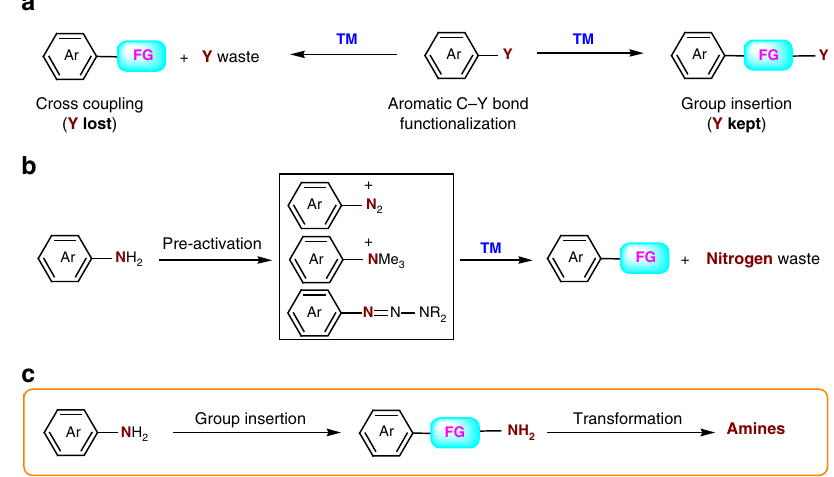
Fig. 1 Functionalization of aryl C – Y bonds: cross-coupling vs group insertion. a functionalization of aromatic C – Y bonds; b conventional functionalization of aryl C – N bonds (nitrogen lost); c functional group insertion into aryl C – N bonds (nitrogen kept). FG functional group, TM transition metal, Ar aryl group. FG in pink and in a cyan rectangle, TM in blue, and Y, N, nitrogen, NH 2 , amines in purple mean emphasis. The different colors used here is for the convenience of